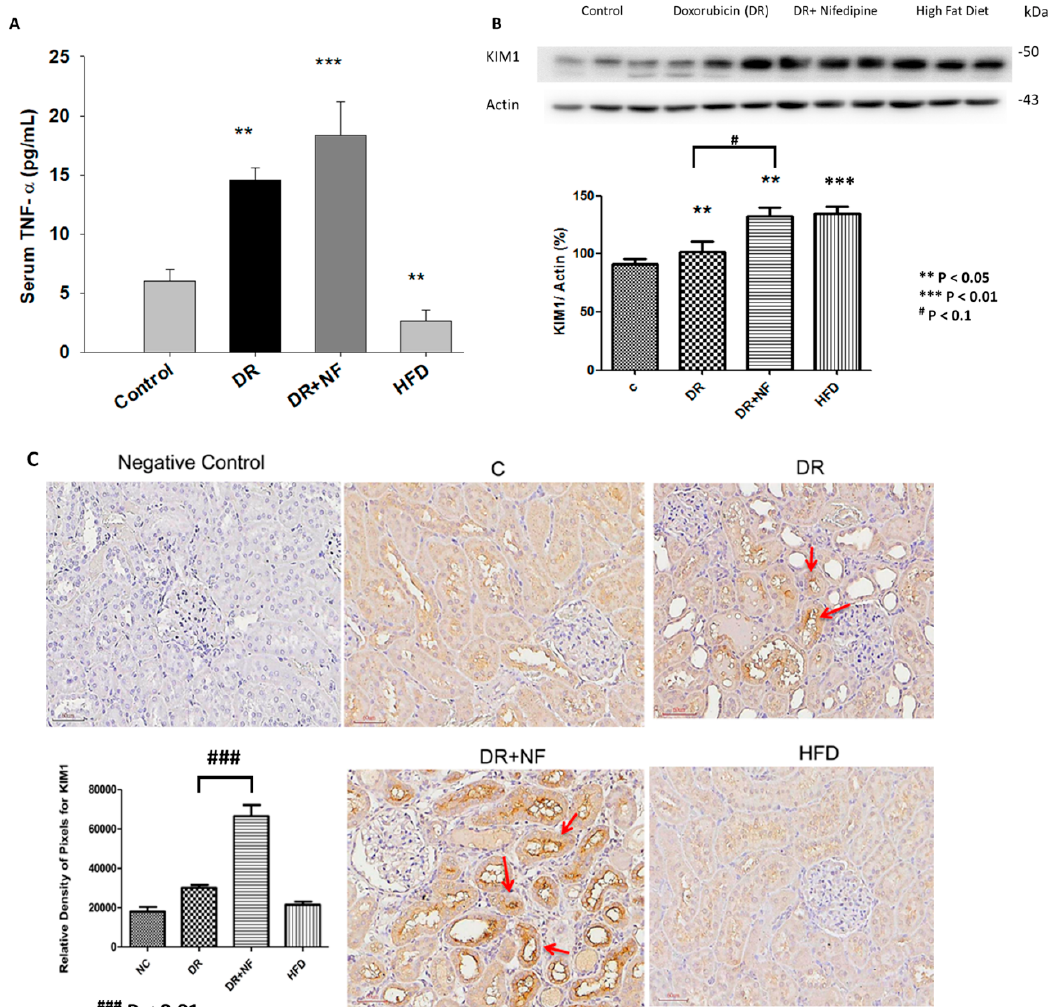
Figure 2. Tumor necrosis factor- α (TNF- α ) and kidney injury molecular-1 (KIM-1) shown in the blood sampling and renal tissue of rats. ( n = 3 for each group) ( A ) ELISA showed that serum TNF- α levels in the DR and DR + NF groups were significantly higher than in the control group (2.46- and 3.08-fold, ** p < 0.05 and *** p < 0.01, respectively), but the high-fat diet (HFD) group had lower TNF- α levels compared to the control (0.54-fold, ** p < 0.05), ( B ) Representative western blotting and quantification of KIM-1 (actin as an internal control ) in renal tissues showed that the KIM-1 of the DR + NF, DR, and HFD group were higher than that in the control group (** p < 0.05); besides, the DR + NF group had higher KIM-1 expression than the DR group (1.33-fold, ** p < 0.05). ( C ) Immunohistochemical staining and quantification of the image showed a higher intensity of KIM-1 in the renal tubules of the DR and DR + NF group (*** p < 0.01). Nifedipine causes much stronger staining of KIM-1 in the DR + NF rats compared to the DR-only group (magnification is 200 ×, ### p < 0.01).